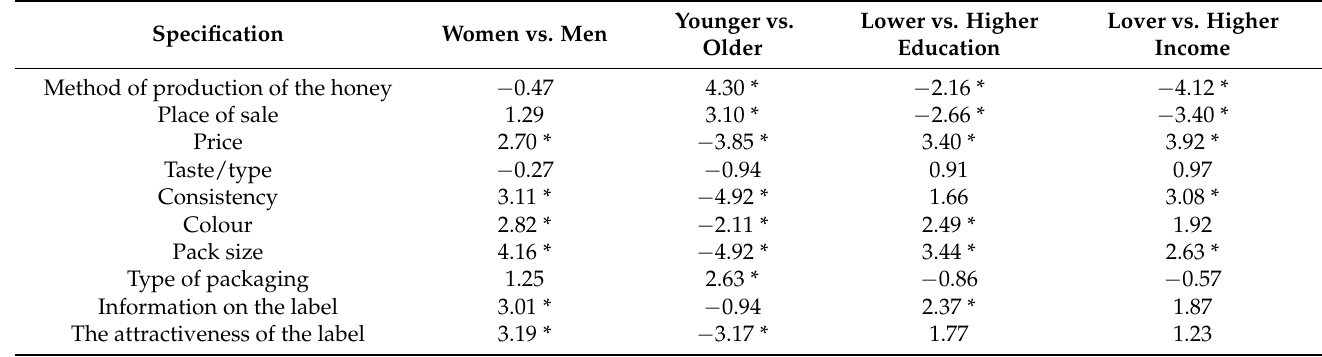
Table 3. Determinants of purchasing decisions regarding choice of honey ( n = 434, Mann–Whitney test). Specification